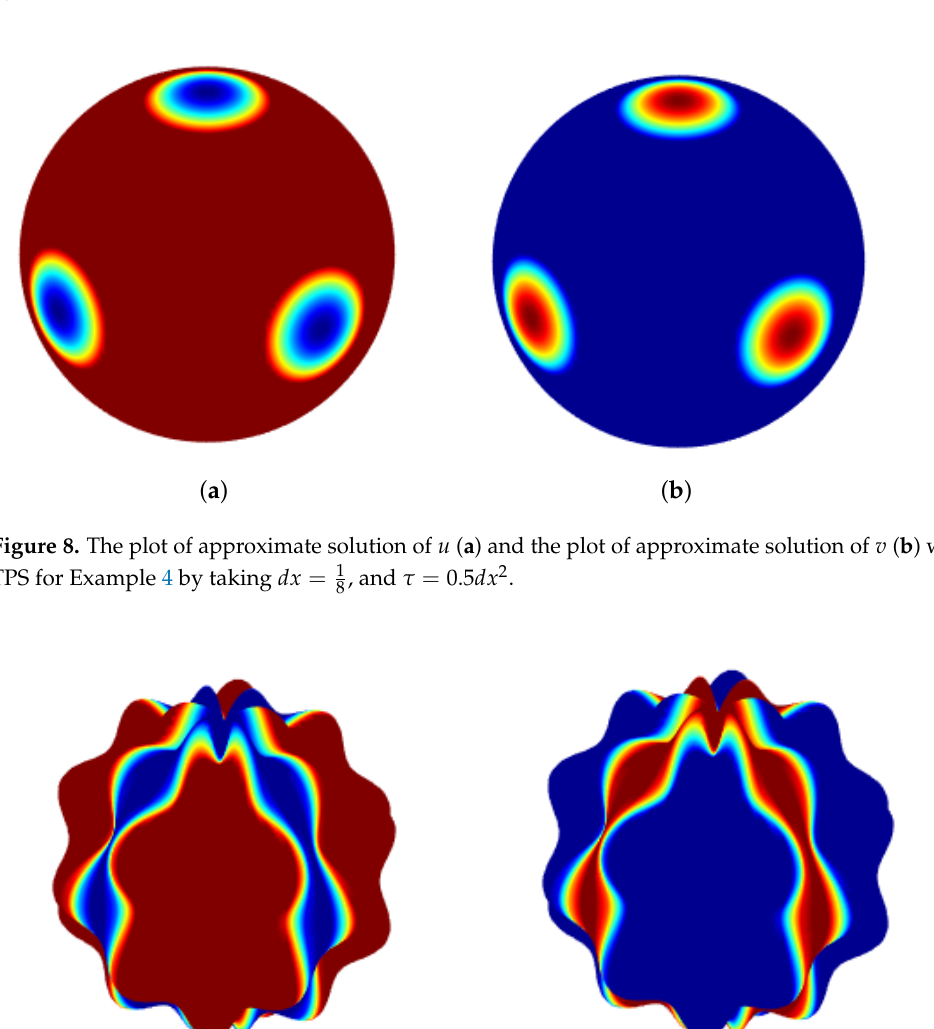
Figure 7. Sparsity pattern for Example 3 with ( a ) TPS and ( b ) MQ by taking dx = 1 n c = 33.